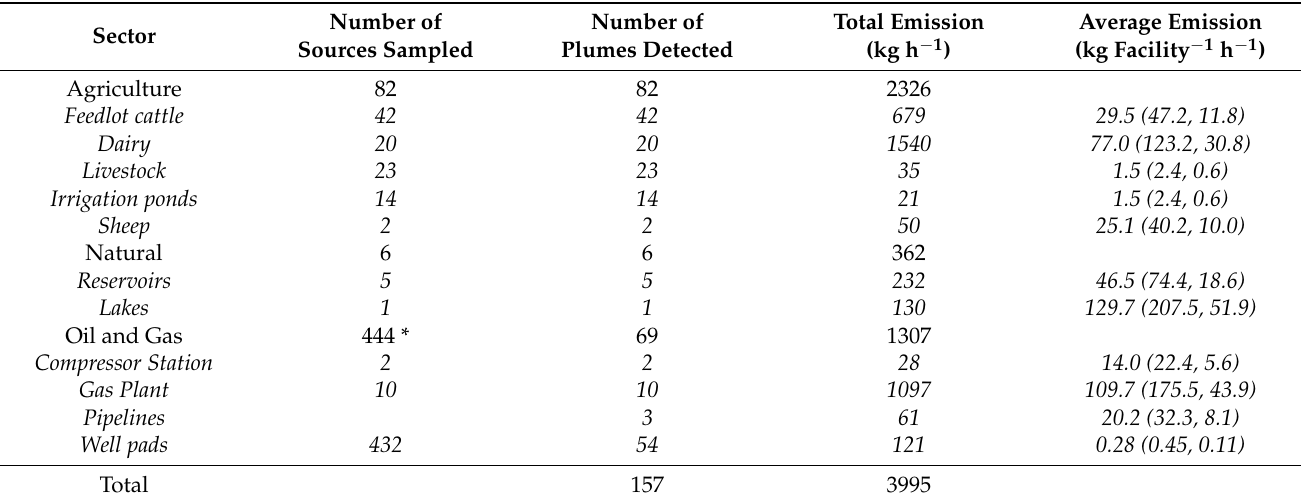
Table 1. The number and total emission estimates from sectors in the DJ Basin detected during weekend/weekday surveys. Sub-sources for sectors or presented in italics and uncertainties in average emission in